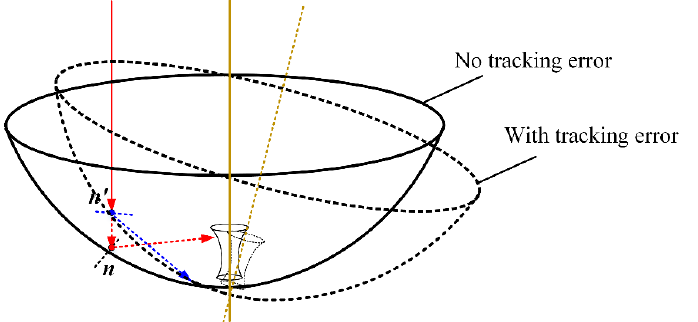
Figure 13. Energy collection and distribution deviation with tracking error.